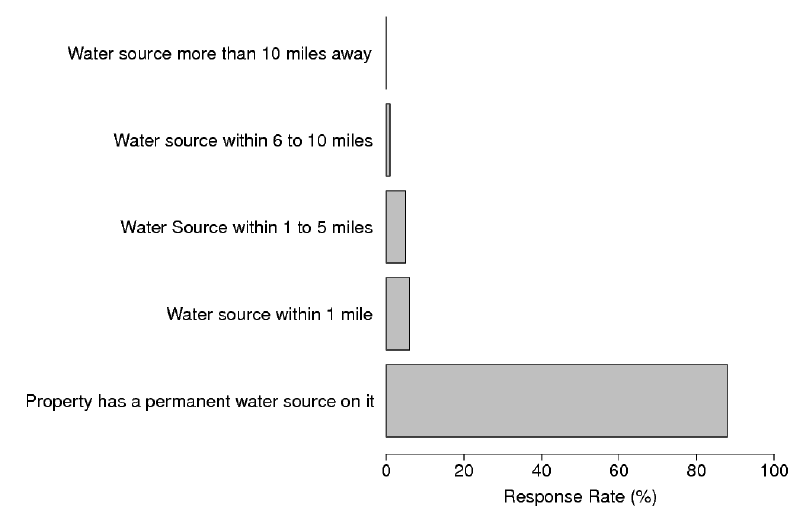
Figure 2. Percent responses of proximity to permanent water source of the property that sustained the most damage in the 2015 flood event and / or the 2016 hurricane among South Carolina Tree Farmers in 45 counties (June–August 2017 data collection).